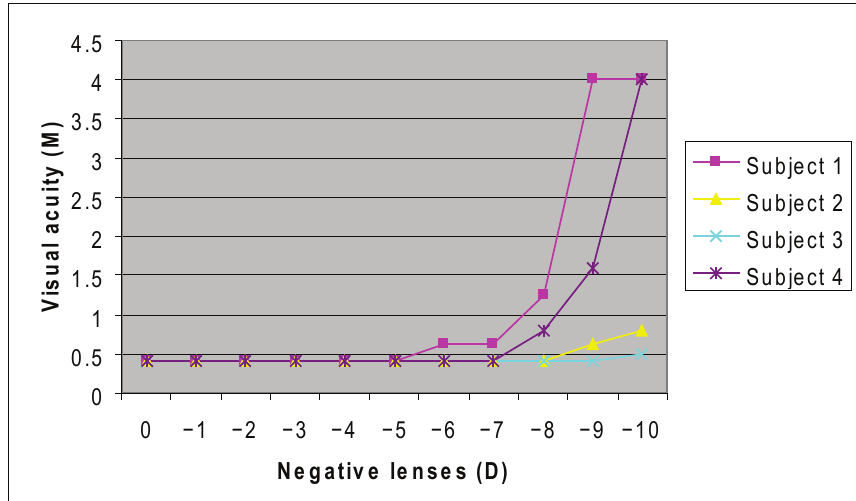
Figure 8. Effect of negative lenses on visual acuity while viewing a near acuity chart at 0.4 m through a pinhole with a 1.5 mm diameter and illumination of 460 lux.